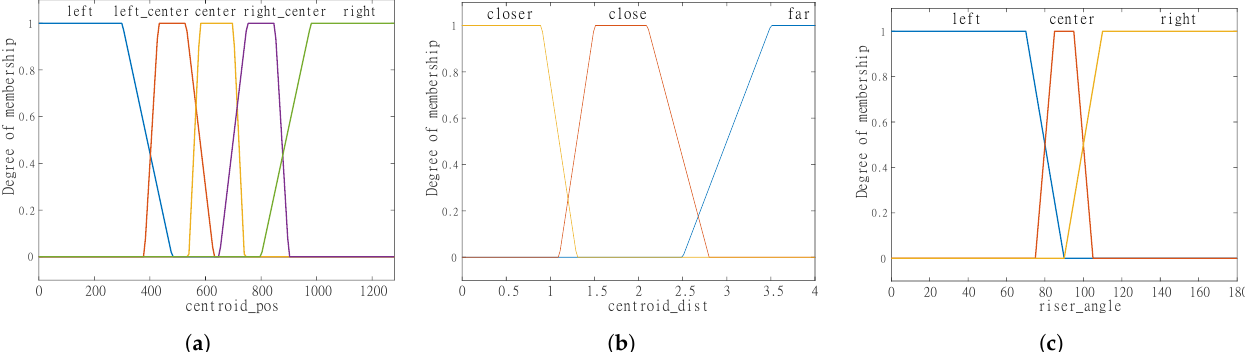
Figure 3. Membership functions for the input variables: ( a ) center of bounding box within the image, ( b ) distance to the centroid of the staircase, ( c ) riser orientation with respect to the camera